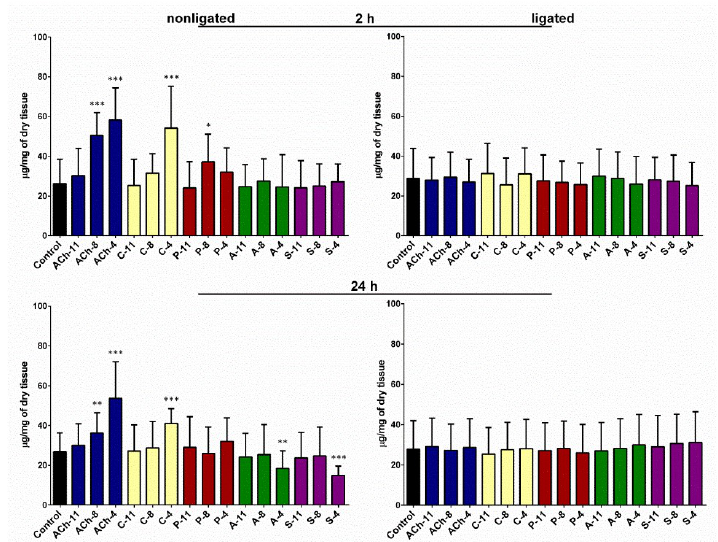
Figure 1. Glycogen content in the fat body of nonligated and neck-ligated larvae of T. molitor beetles injected with acetylcholine (ACh), carbachol (C), pilocarpine (P), atropine (A), and scopolamine (S) at concentrations of 10 − 11 (X-11), 10 − 8 (X-8) and 10 − 4 M (X-4) for each compound. The samples were isolated 2 or 24 h after injection. The control larvae were treated with saline. Mean values ± SD are given for 15–25 individuals. Statistically significant differences from the control values are indicated by asterisks (Student’s t -test), where * p ≤ 0.05, ** p ≤ 0.01, and *** p ≤ 0.001.